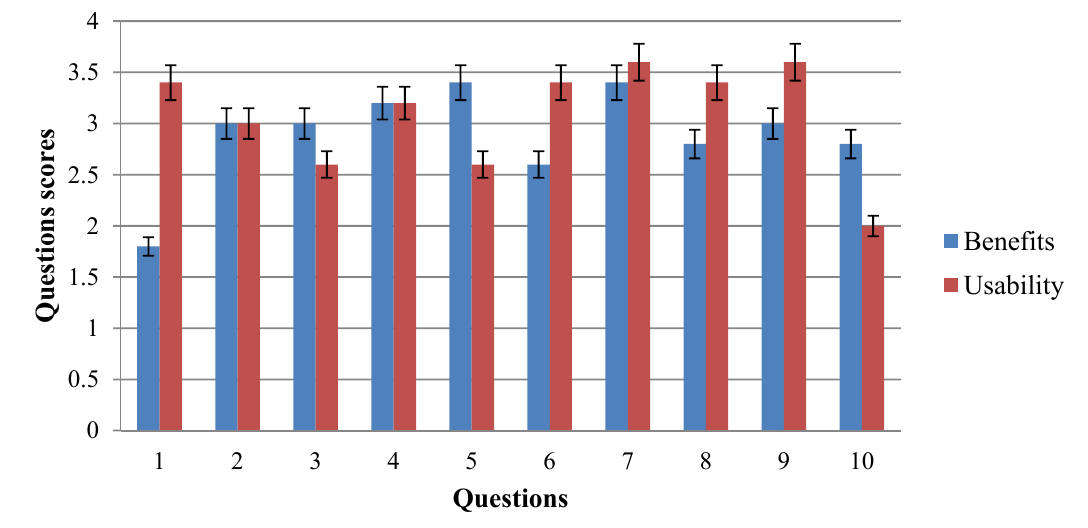
Figure 10. Questions values of questionnaire no. 1 and no.